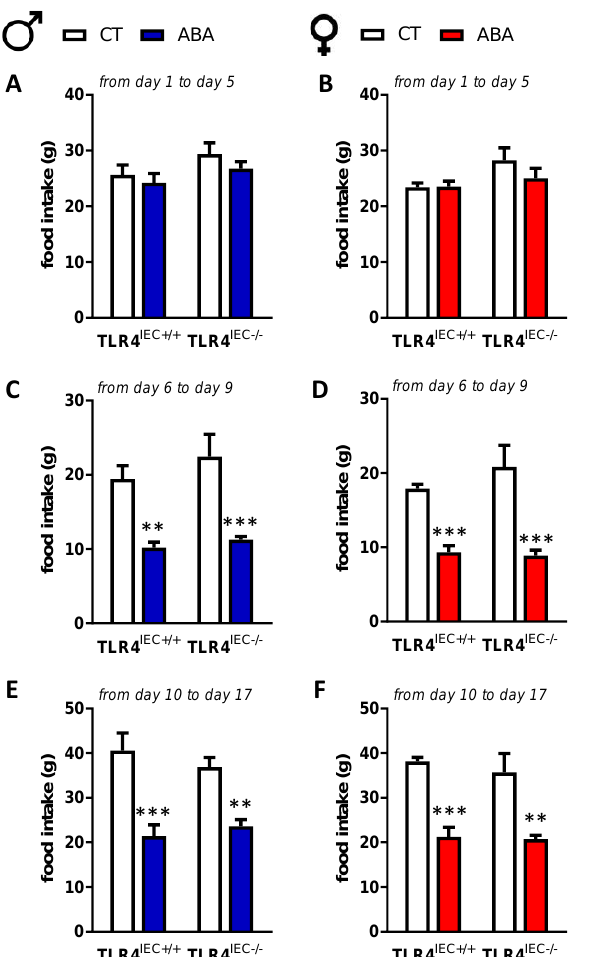
Figure 2. Food intake in male and female mice. Food intake was measured during the adaptation phase (from day 1 to day 5, A , B ), the progressive limitation of food access (from day 6 to day 9, C , D ) and during the 3-h limited food access (from day 10 to day 17, E , F ) in male TLR4 IEC+/+ and TLR4 IEC − / − control (CT, open bars) and ABA (blue bars) mice or in female TLR4 IEC+/+ and TLR4 IEC − / − control (CT, open bars) and ABA (reds bars) mice. The results of the Bonferroni post hoc tests are shown: **, p < 0.01 and ***, p < 0.001 vs. CT.